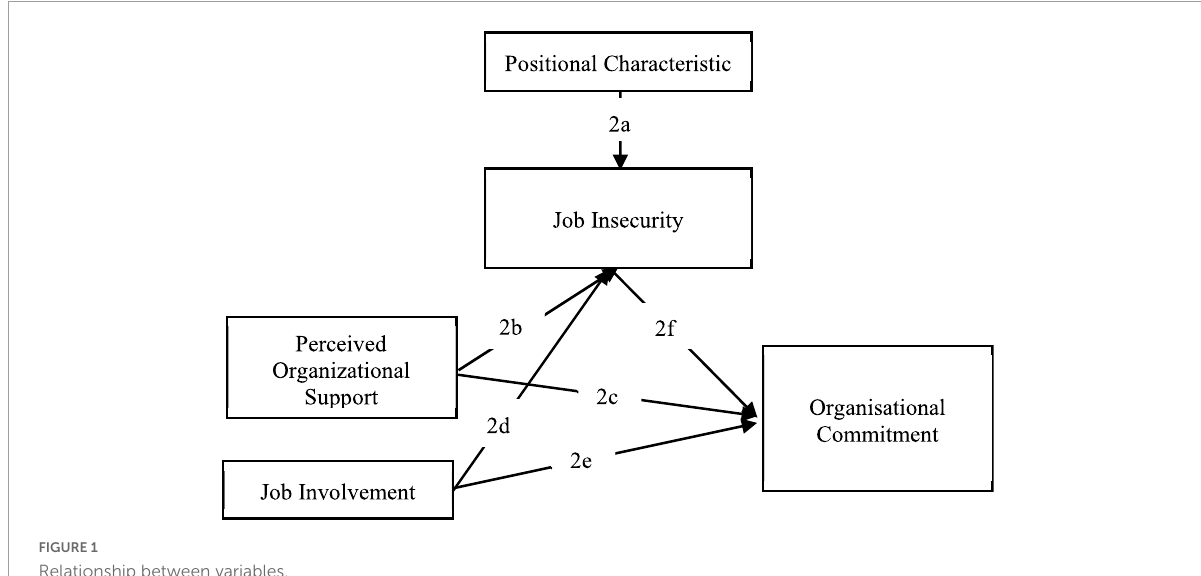
FIGURE1 Relationship between